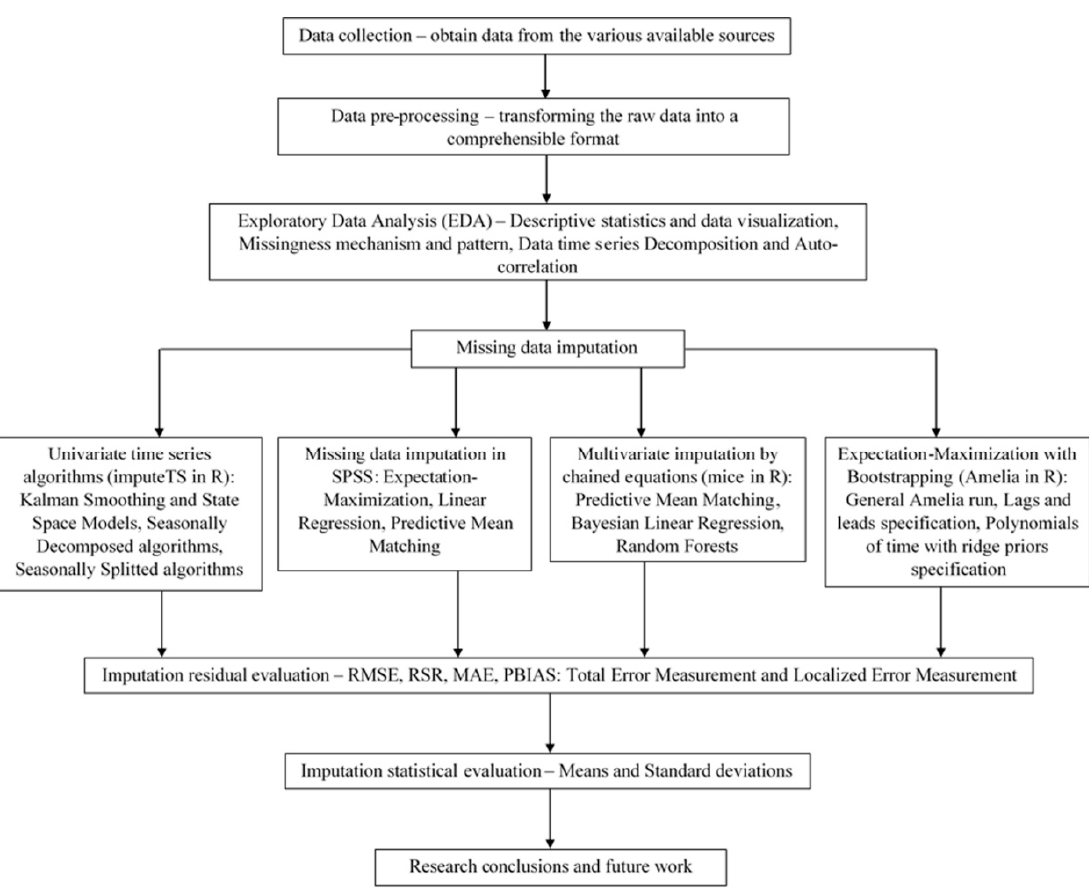
Figure 2. The research design process implemented in this study.